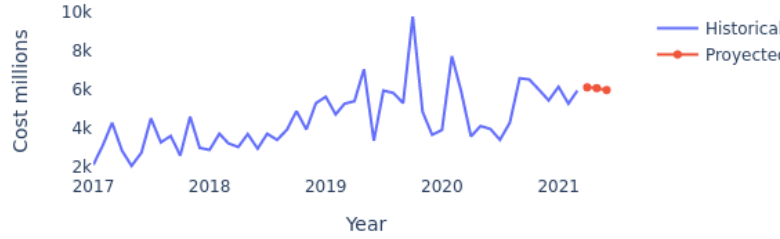
Figure 12. Cluster 3 medical cost projection.